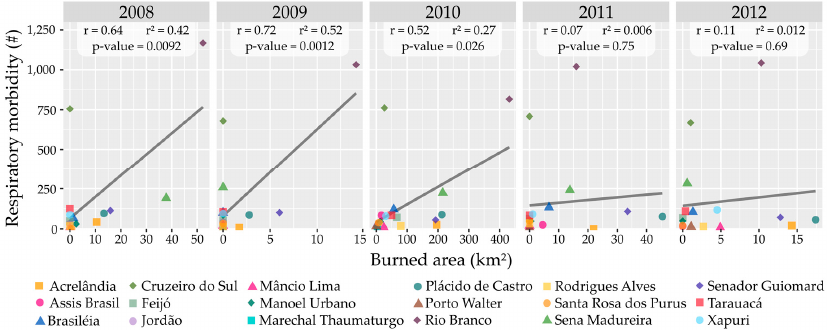
Figure 7. Correlation between respiratory morbidity and burned area by year analyzed, with the determination coefficient value (r²), the correlation coefficient value (r), and the specific p